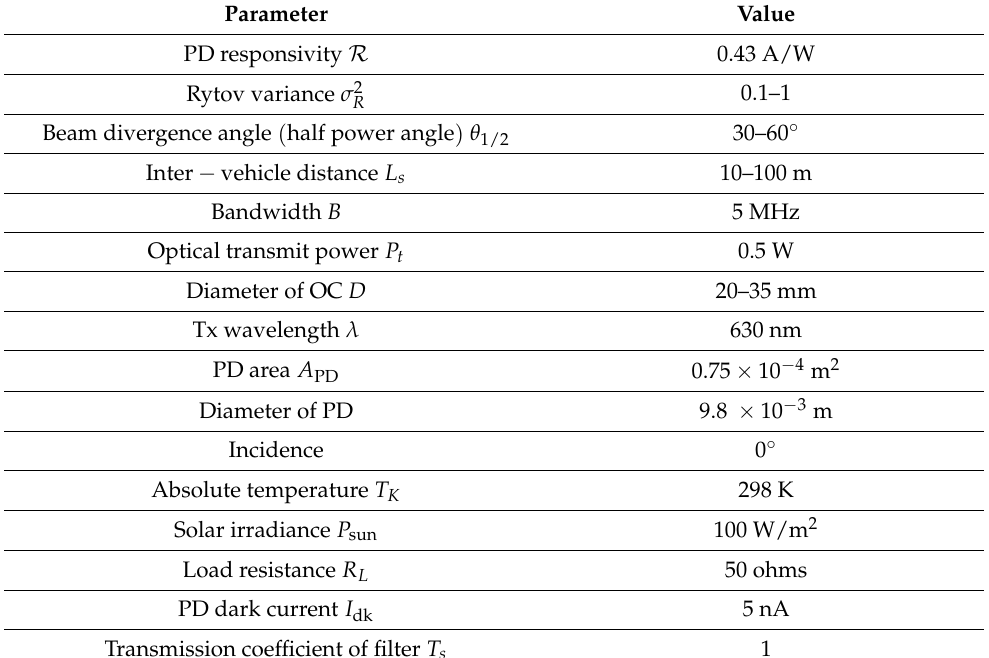
Figure 1. Bit error rate (BER) performance without and with weak to moderate atmospheric turbu-